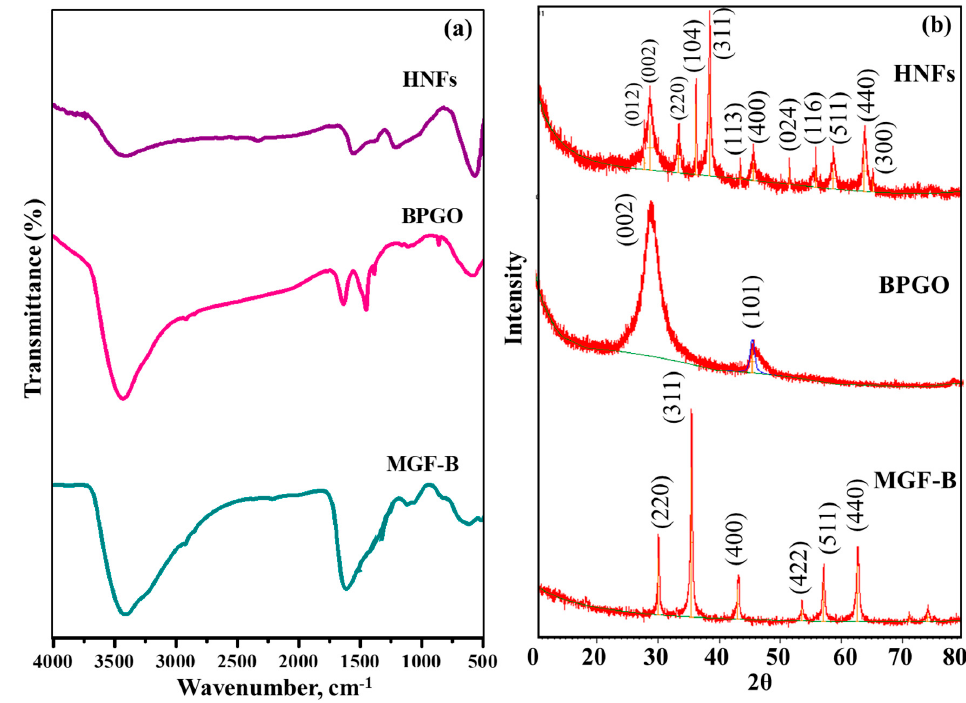
Figure 3. ( a ) FT–IR spectra and ( b ) XRD diffractogram of MGF–B, BPGO and HNFs. Figure 3. ( a ) FT − IR spectra and ( b ) XRD diffractogram of MGF − B, BPGO and HNFs. The XRD pattern of MGF-B (Figure 3b) displayed all the peaks of MgFe 2 O 4 (2theta = 30.1 ◦ , In GO, the XRD diffraction peaks at 2theta values of 10.9°and42.7°can be indexed to 35.4 ◦ , 43.1 ◦ , 53.5 ◦ , 57.0 ◦ and 62.6 ◦ indexed to hkl planes of (220), (311), (400), (422), (001) and (101) hkl planes of graphitic carbon, respectively (Figure S1) [33]. After co- doping (Figure S1), the fingerprint diffraction peak of GO at 2 θ = 10.9°disappeared. Low